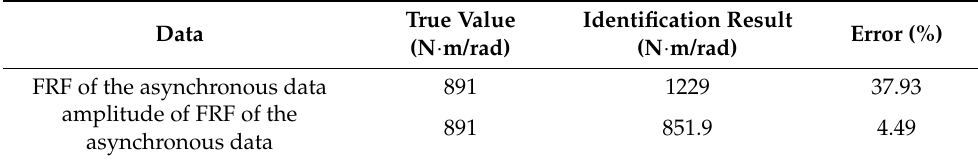
Table 3. Stiffness identification results of the FRF and the amplitude of FRF.